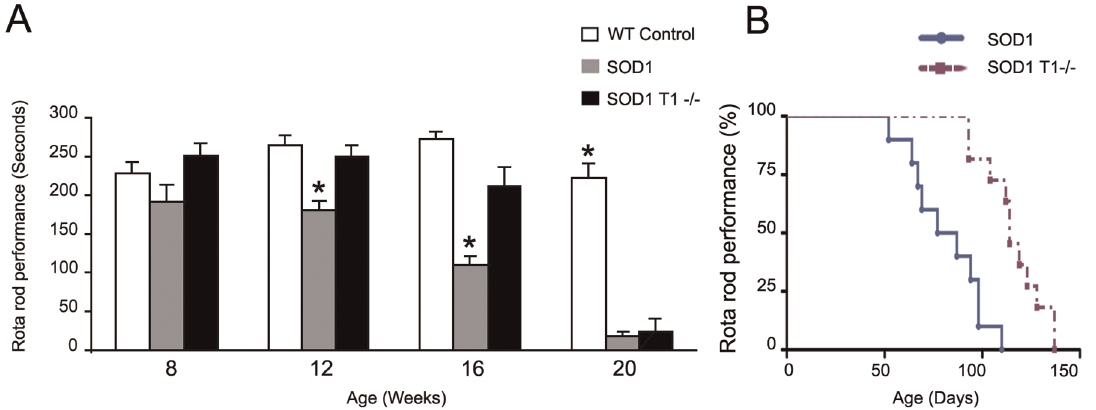
Figure 2. Deletion of TrkB.T1 improves the motor performance of SOD1 transgenic mice on rotarod in the early phase of the disease. (A) Histogram showing the rotarod performance of WT, SOD1 and SOD1T1 2 / 2 animals at 8, 12, 16 and 20 weeks. At 8 weeks, both SOD1 and SOD1 T1 2 / 2 animals perform similarly to controls although SOD1 mice show some impairments. With disease progression, the SOD1 transgenic mice show a significant reduction in the amount of time spent on the rotarod at 12 and 16 weeks as compared to controls. A slight loss of motor performance is evident only at 16 weeks in the SOD1T1 2 / 2 animals, although by 20 weeks the SOD1 and SOD1;T1 2 / 2 groups are indistinguishable. The data are the Mean 6 SEM. * P , 0.05. N $ 7. Statistical analysis by ANOVA followed by post-hoc Tukey test. (B) Kaplan-Meier analysis of the SOD1 and SOD1T1 2 / 2 mice rotarod performance in relation to their age. Note that deletion of TrkB.T1 in the SOD1 transgenic mice delays the impairment in rotarod performance by 34 days (81.6 6 5.87 days, n=10 in SOD1 versus 115.8 6 6.80, n=7 in SOD1 T1 2 / 2 , p , 0.05).